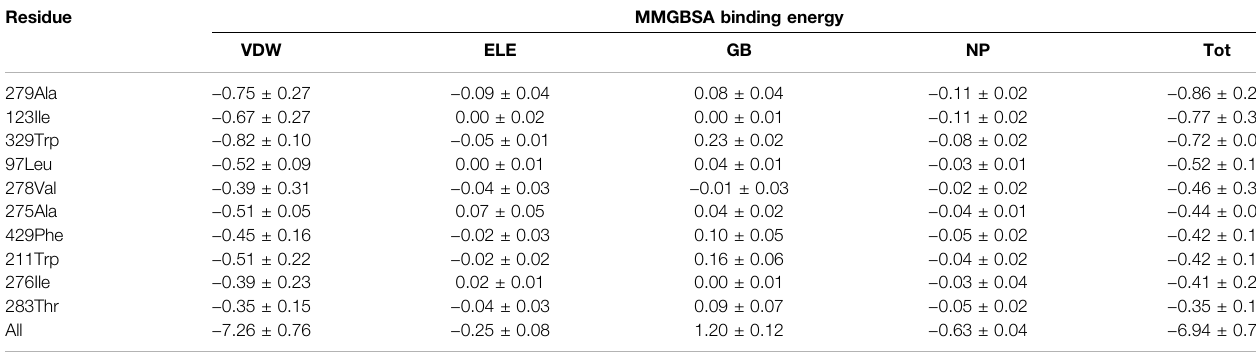
TABLE 1 | MMGBSA binding energy decomposition of the CYP450 wild type binding with styrene (all units are in kcal/mol).